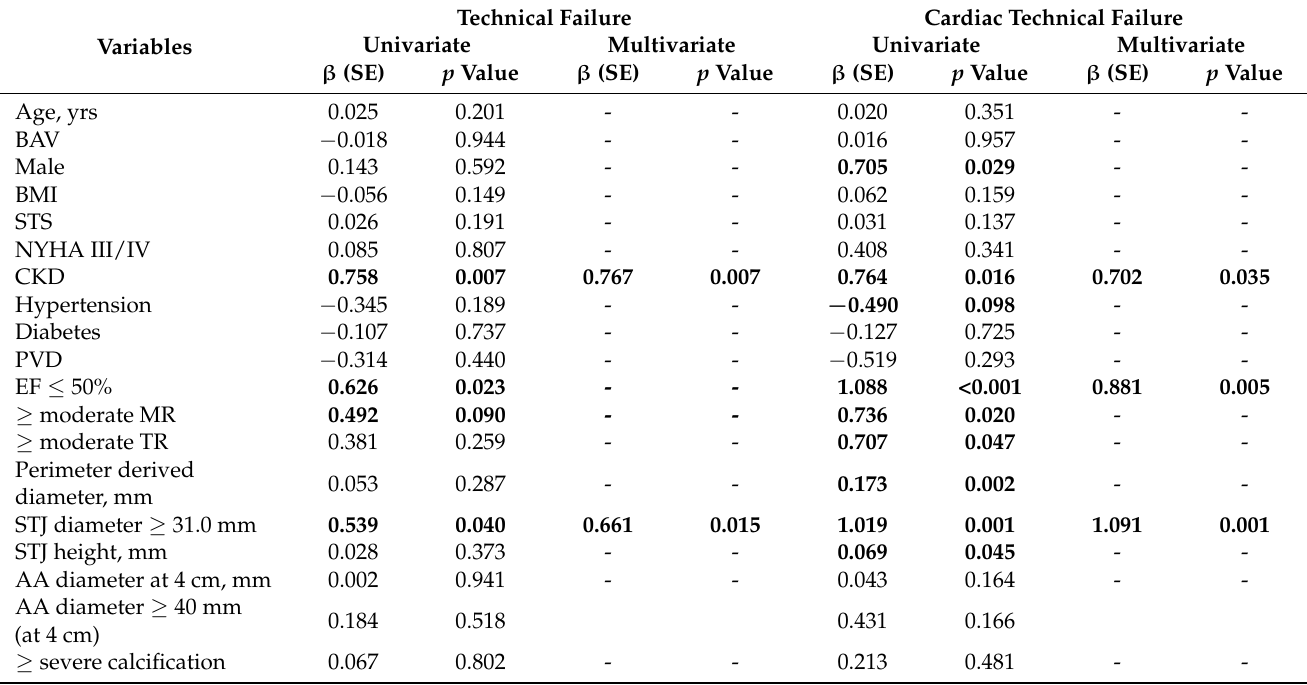
Table 5. The Adjusted Association of the Relevant Variables with technical success and cardiac technical success, Using Logistic Regression analysis using a Likelihood Ratio